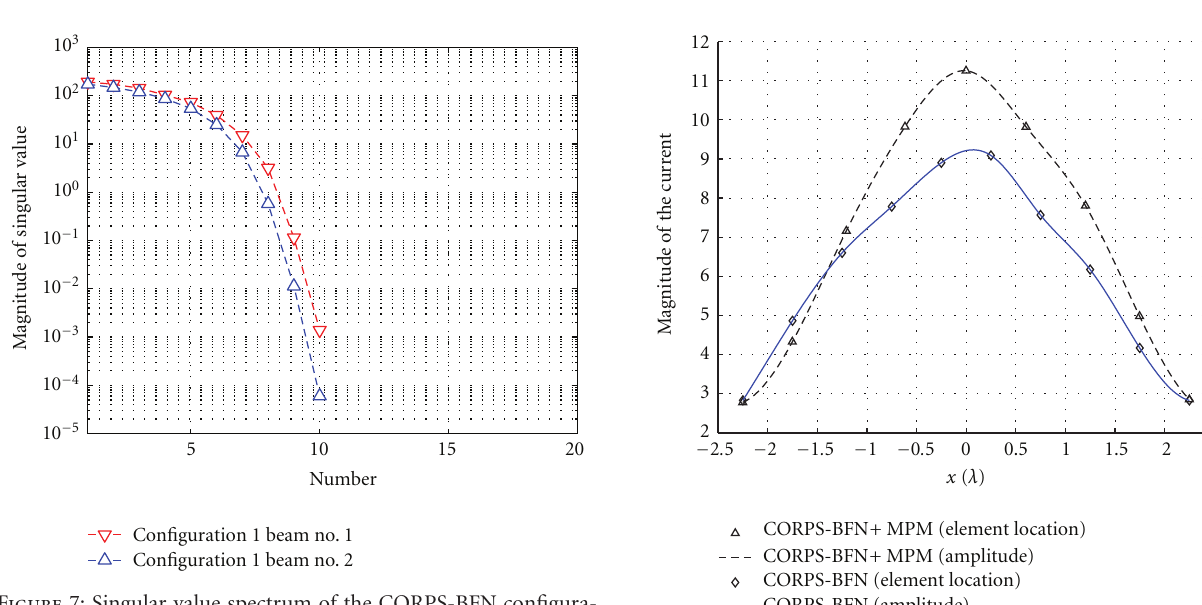
Figure 7: Singular value spectrum of the CORPS-BFN configura- tion 1, for the example based in Figures 4 and 5.